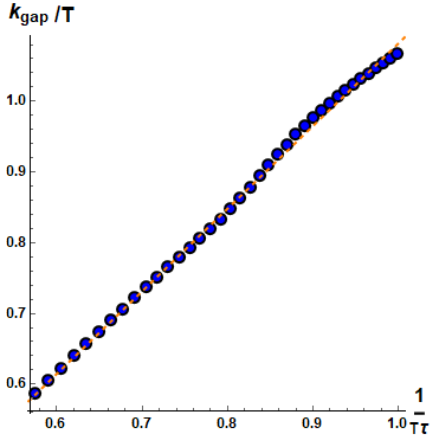
Figure 18 . The k-gap in function of the inverse relaxation time (cid:28) (4.33). The straight dashed line is a guide for the